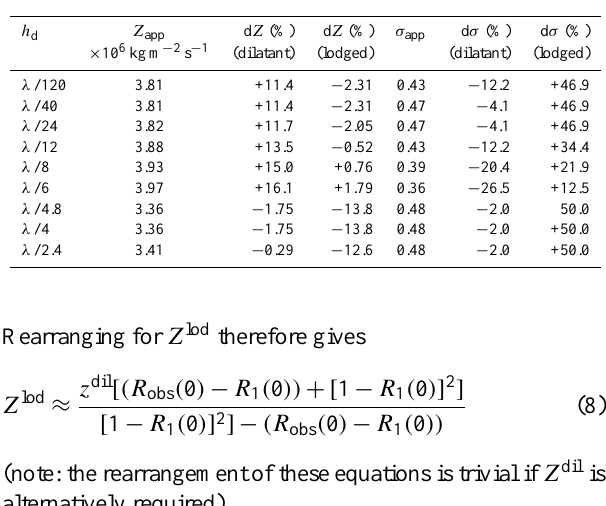
Table 3. Apparent acoustic impedance, Z app , and Poisson’s ratio, σ app , as measured from responses in Fig. 5 if thin-layer consdier- ations were ignored in AVA interpretation. d Z and d σ show the mismatch between observed and model properties for the dilatant and lodged till units. Modelled acoustic impedances of dilatant and lodged till are 3.42 and 3 . 90 × 10 6 kgm − 2 s − 1 , respectively; equiv- alent Poisson’s ratios are 0.49 and